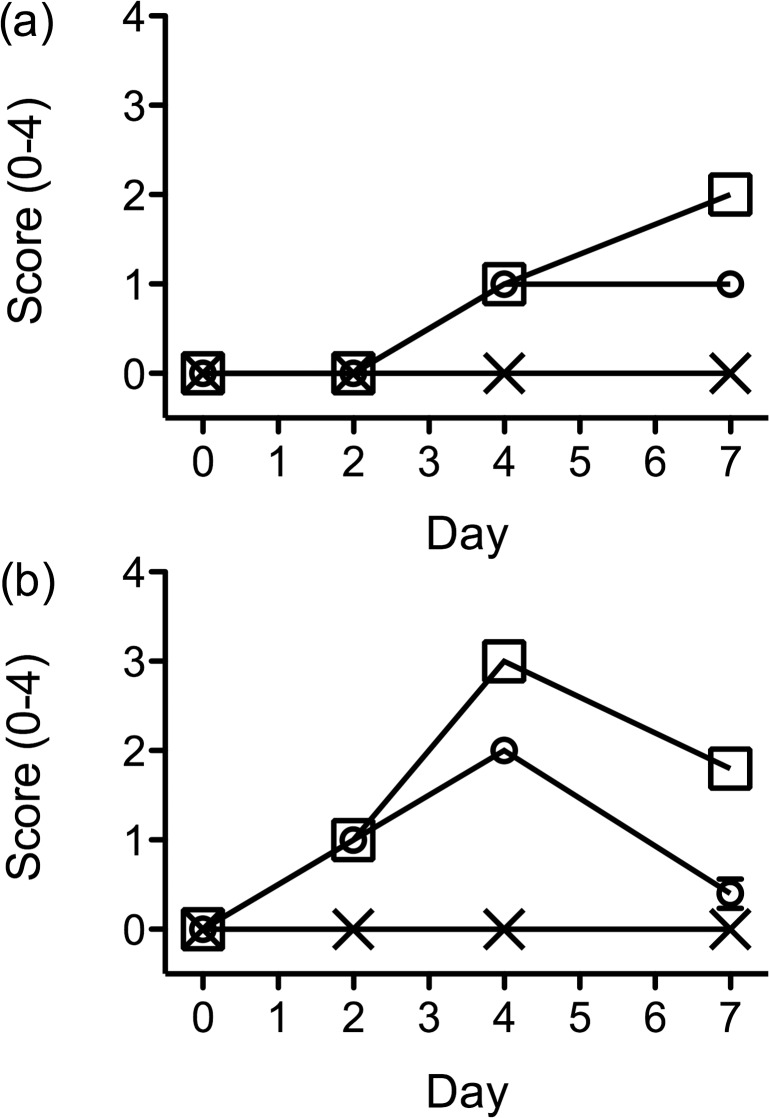
Erythema and scales score of the skin on the backs BALB/c mice.Scoring was performed on days 0, 2, 4 and 7 using the erythema and scales elements of the Psoriasis Area Severity Index (PASI) to assign a score of 0–4 to each animal and thereby assess the effects of daily treatment with Imiquimod cream and vehicle cream. (a) Erythema score: Data points are presented as group means ±SEM (n = 8, n = 10, n = 10 for controls, IMQ and IMQ-RSV respectively) (X = control group, O = IMQ-RSV group, □ = IMQ group). (b) Scales score: Data points are presented as group means ±SEM (n = 8, n = 10, n = 10 for controls, IMQ, IMQ-RSV respectively) (X = control group, O = IMQ-RSV group, □ = IMQ group).